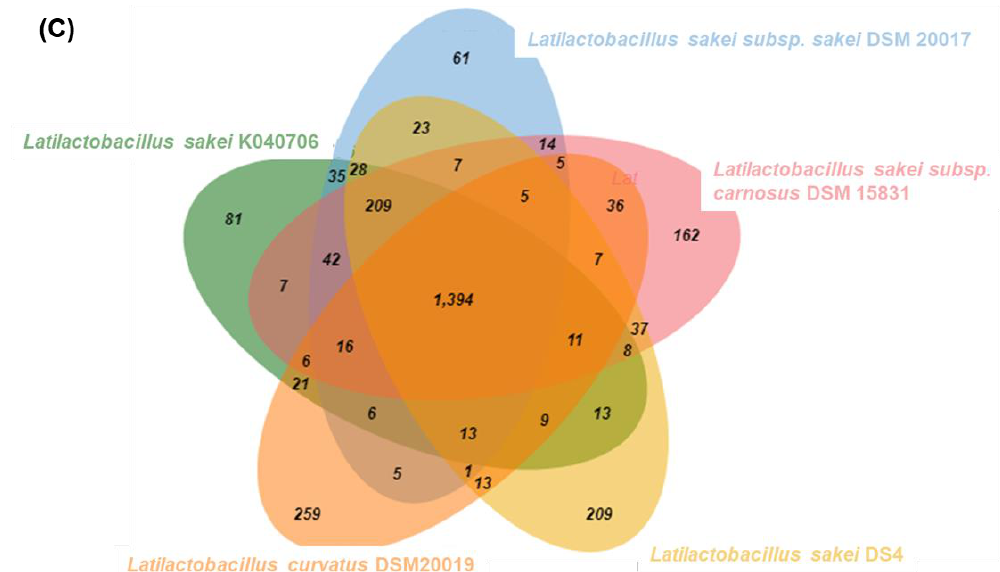
Figure 2. ( A ) Phylogenetic tree showing the relatedness of L. sakei strains based on ANI analysis. ( B ) Core and pan-genome curves show the trend of the core gene and pan-gene families with an increase in the number of genomes by Heap’s law model. ( C ) Pan-genome Venn diagram of L. sakei strains, including K040706, DSM 20017, DSM 15831, DS4, and DSM20019, showing the distribution of shared and unique pangenome orthologous groups (POGs) among the five strains.